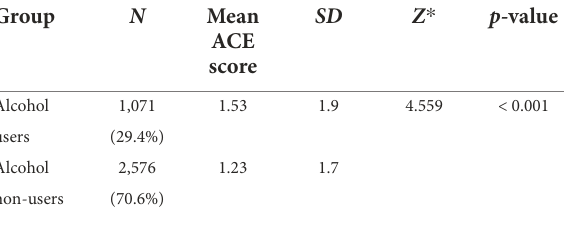
TABLE 5 Groups of alcohol users and non-users - descriptive statistics of ACE score. Group